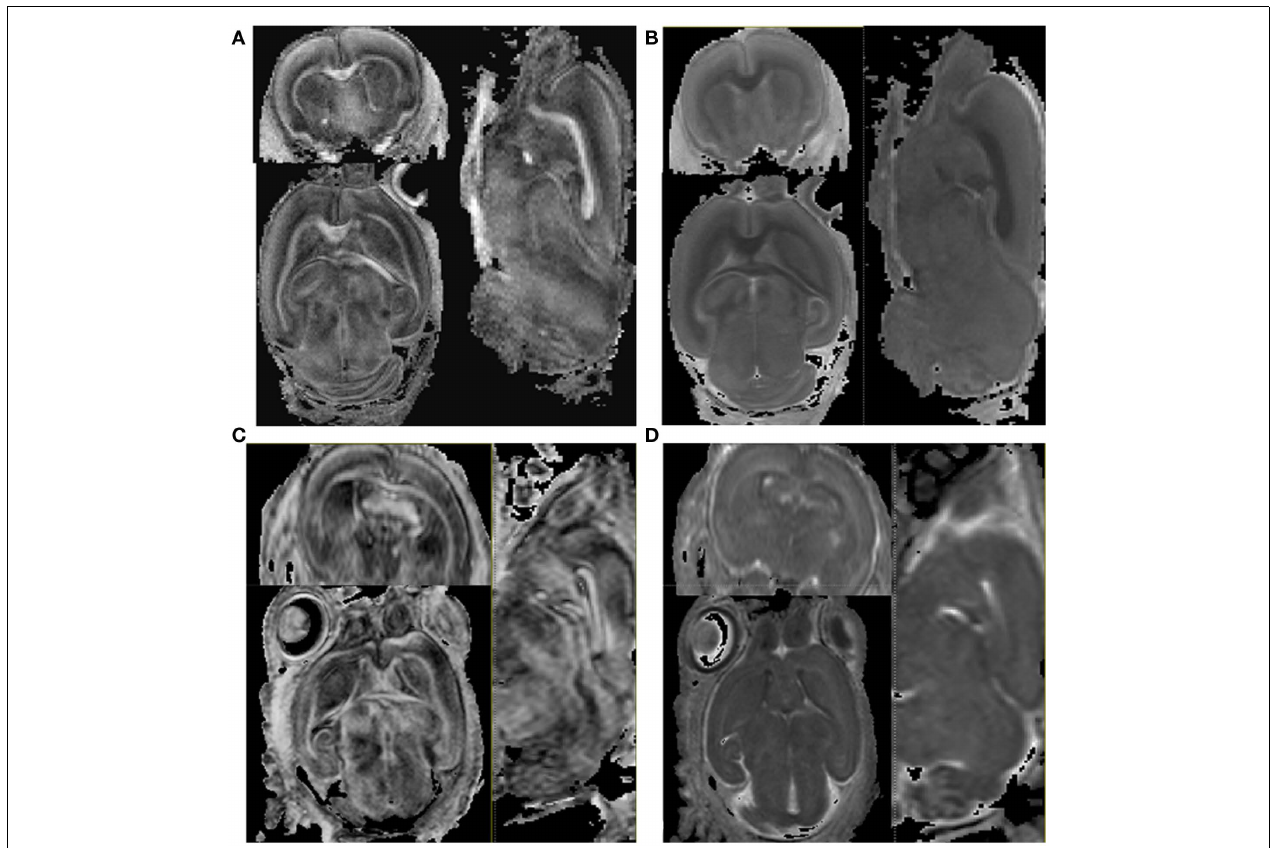
FIGURE 2 |The comparison of FA and MD maps between the ex vivo and the in vivo scan. (A) Ex vivo baseline image. (B) Ex vivo diffusion weighted